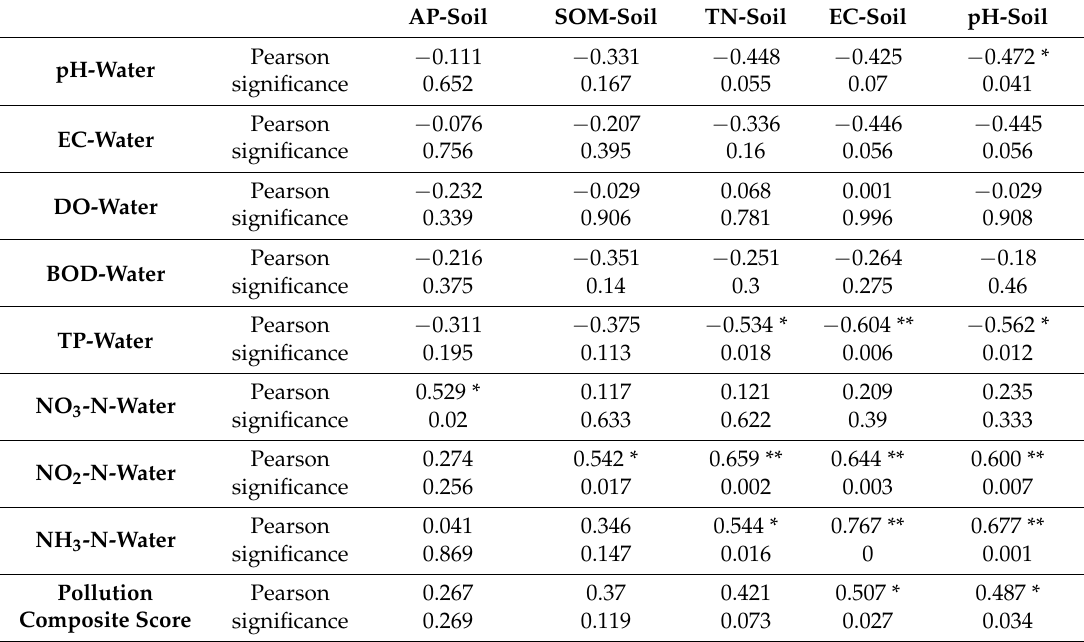
Table 11. Correlation of water quality and soil in rainy